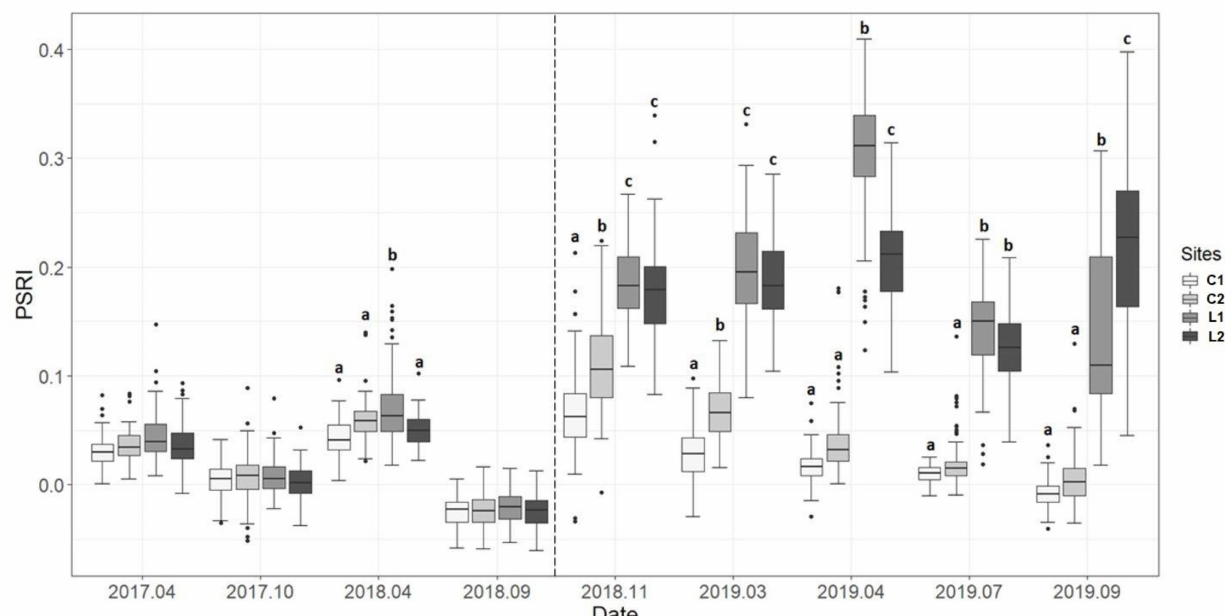
Figure 3. Median values, 25th and 75th percentiles of Plant Senescence Reflectance Index (PSRI) temporal profiles for control (C1 and C2) and study sites (L1, L2) for each of the dates reported in Table 1. Letters denote statistical significance between control and wind-damaged sites index values ( p -value < 0.05). The dash line separates pre and post-Vaia dates. Table 3. Generalized Least Square (GLS) models coefficients (intercept and treatment), standard error (SE), p value and variance explained (R 2 ) for NDWI8A, NDWI, NDVI, PSRI, SLAVI, GNDVI,